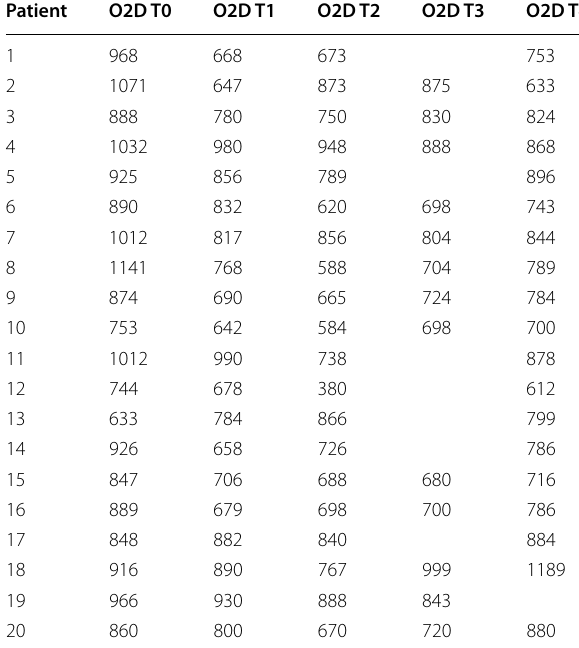
Table 4 Group I Patient Oxygen Delivery (DO2)